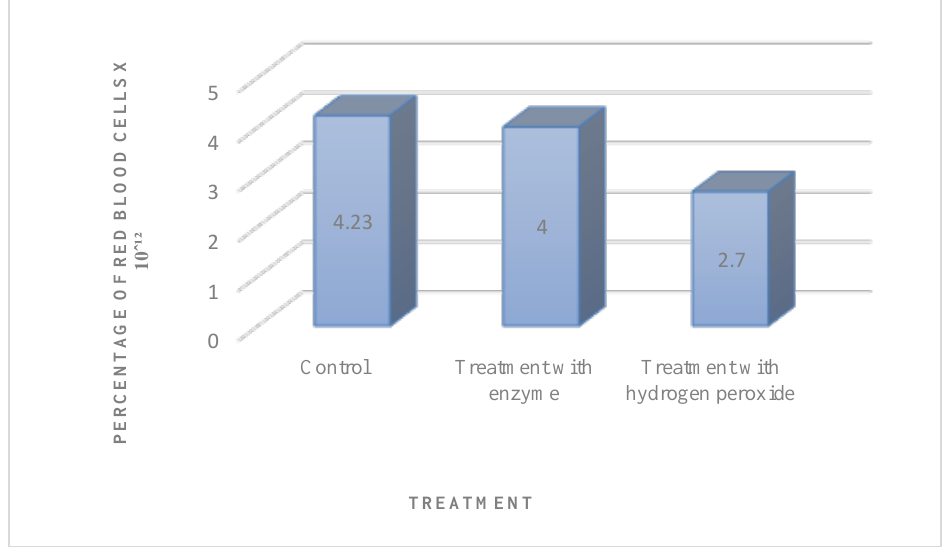
Figure 6. The effect of the studied treatments on the percentage of red blood